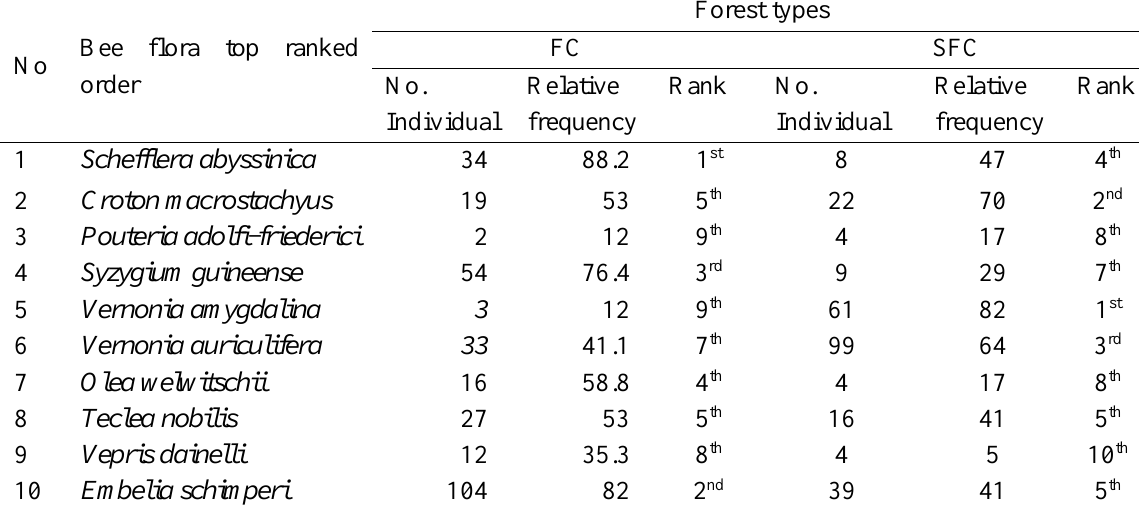
Table 4 Relative frequency of top ranked bee flora of FC and SFC sites Bee flora top ranked No